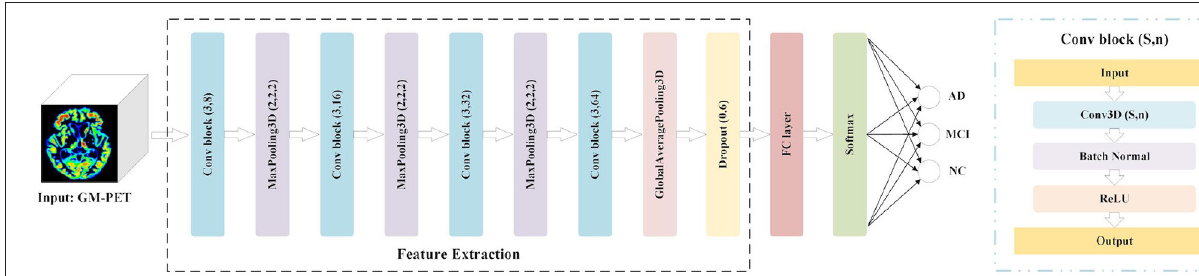
FIGURE 3 | 3D Simple CNN architecture for AD classification.